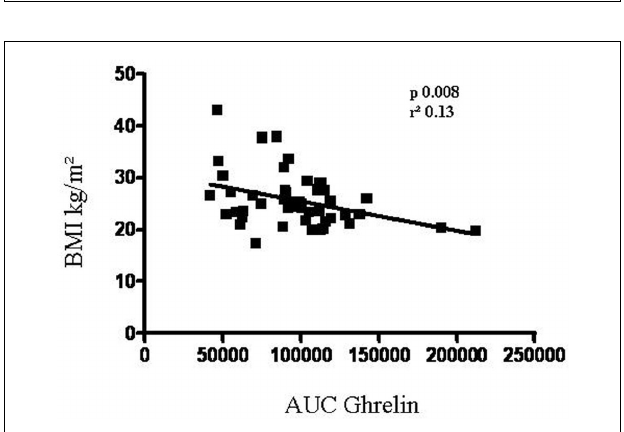
FIGURE 2 | Correlation between ghrelinAUC after rhTSH administration and